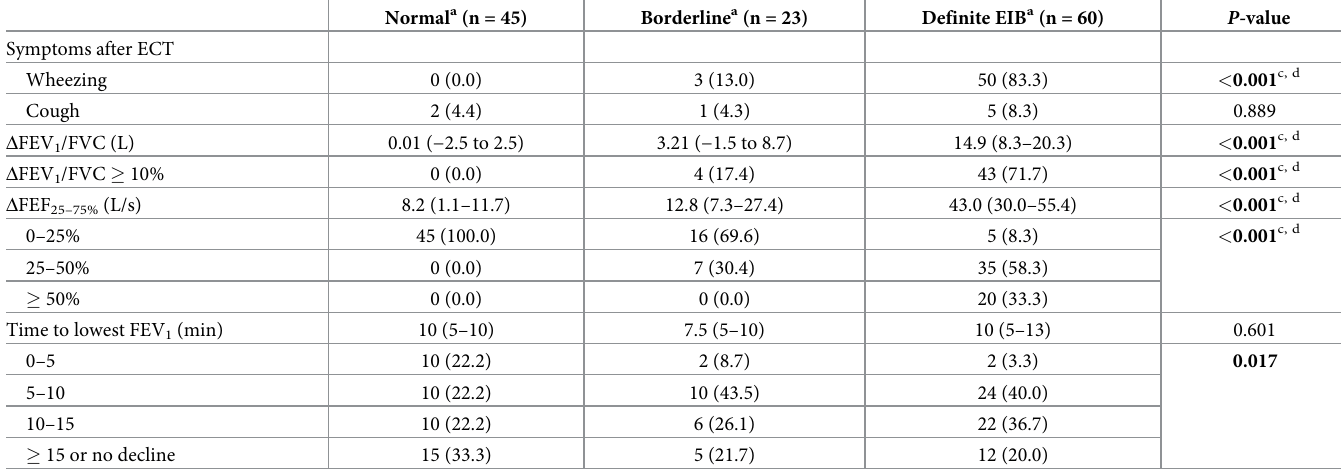
Table 2. Changes in symptoms and pulmonary function test results after